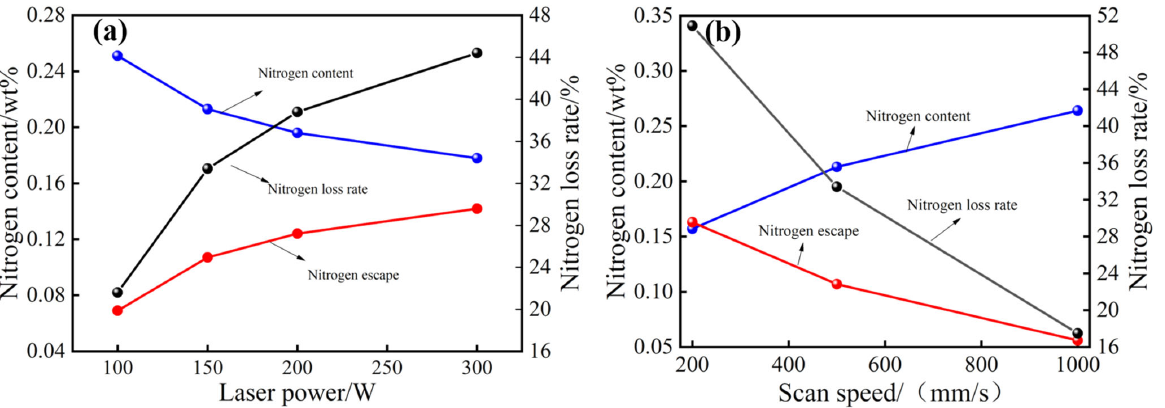
Figure 3. Nitrogen emission of SLM sample: ( a ) di ff erent laser power; ( b ) di ff erent scan speed.